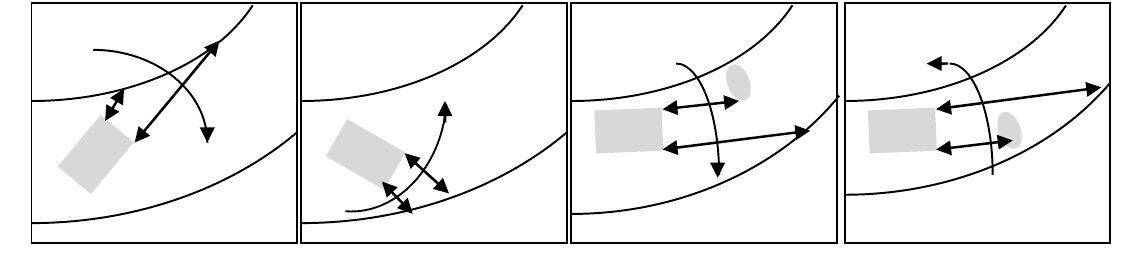
Figure 3. Decision making regarding steering left or